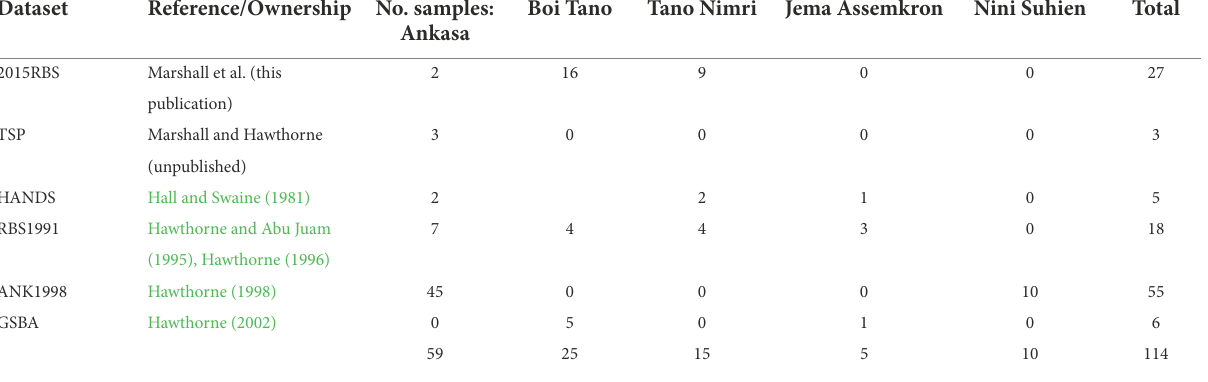
TABLE 1 Datasets compiled for SW Ghana.